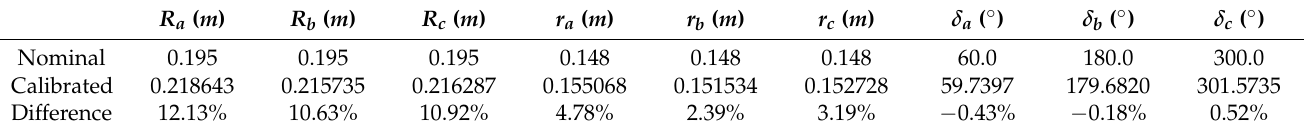
Table 5. Nominal and calibrated kinematic parameters (strategy STE-GA5) of the mobile robot.